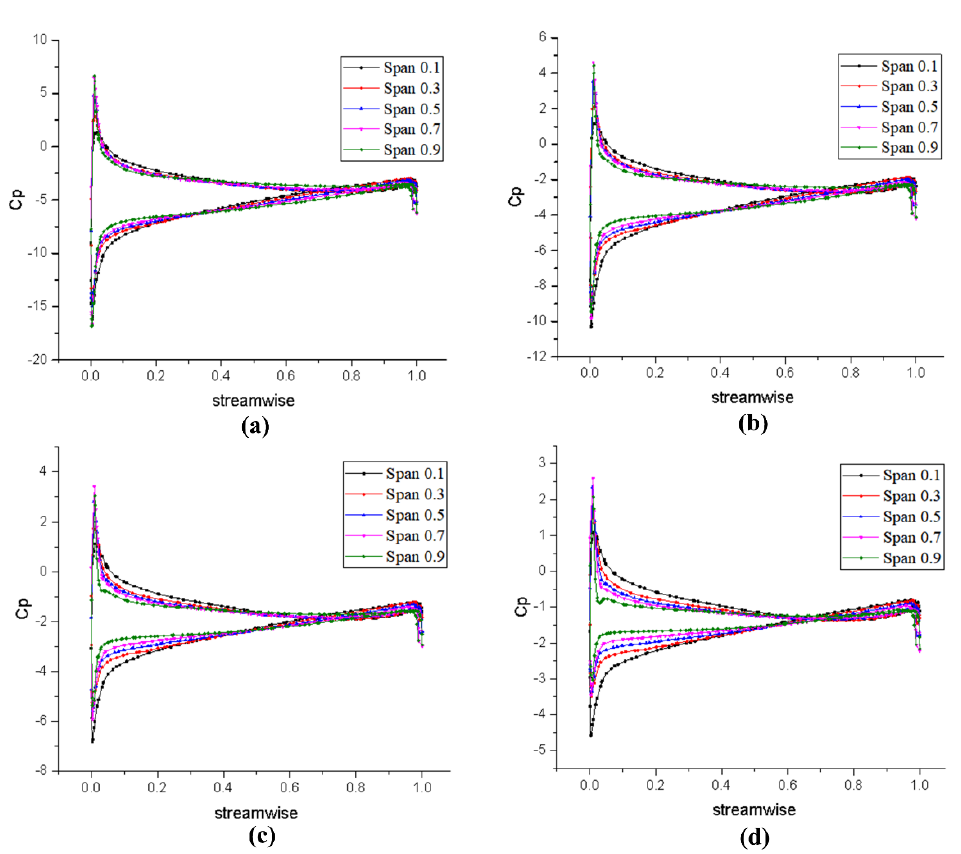
Figure 26. Tangential pressure distribution of rotor after optimization: ( a ) v = 7 m/s ( J = 0.78), ( b ) v = 8.5 m/s ( J = 0.95), ( c ) v = 10 m/s ( J = 1.12), and ( d ) v = 11.5 m/s ( J = 1.28).